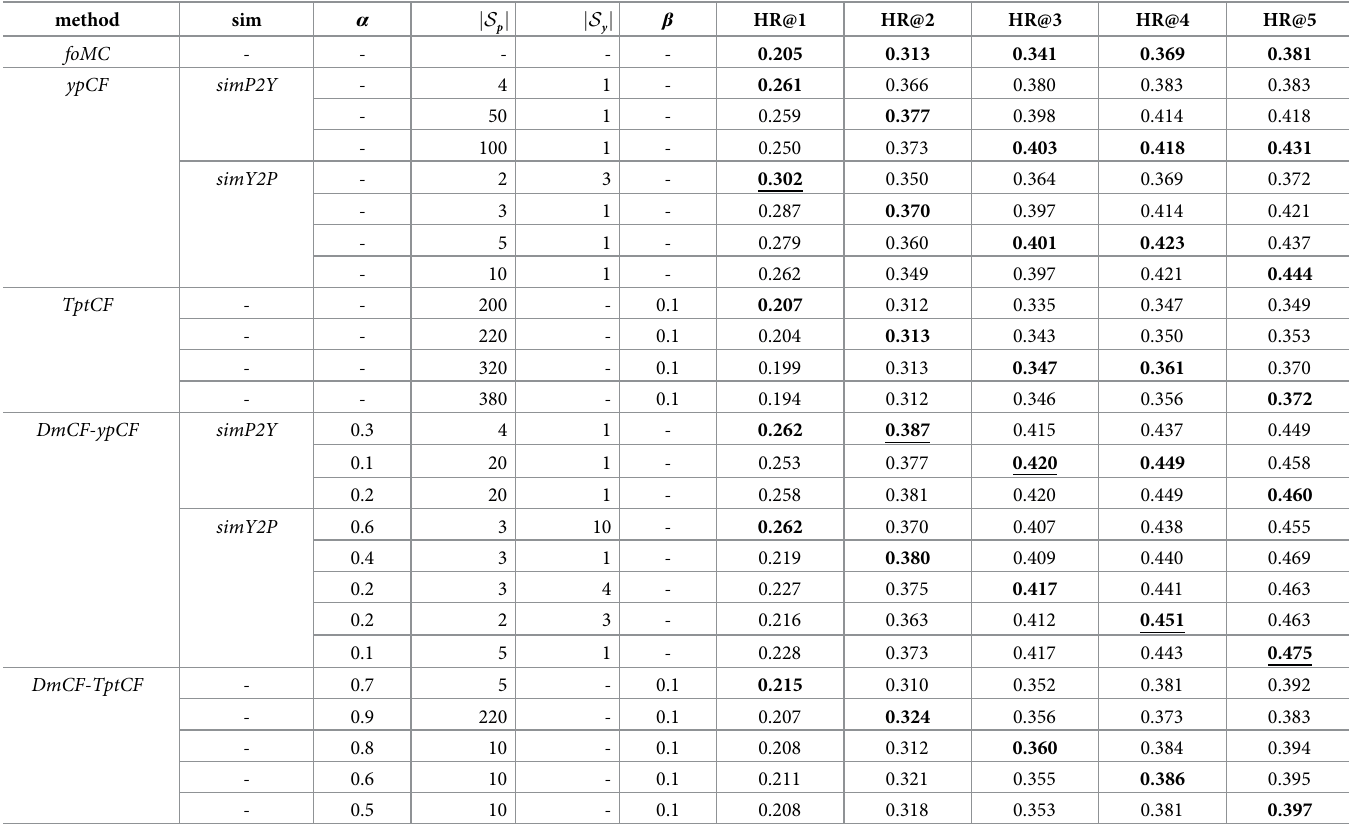
Table 6. Overall performance of all methods for CUTOFF 06/26/2013.